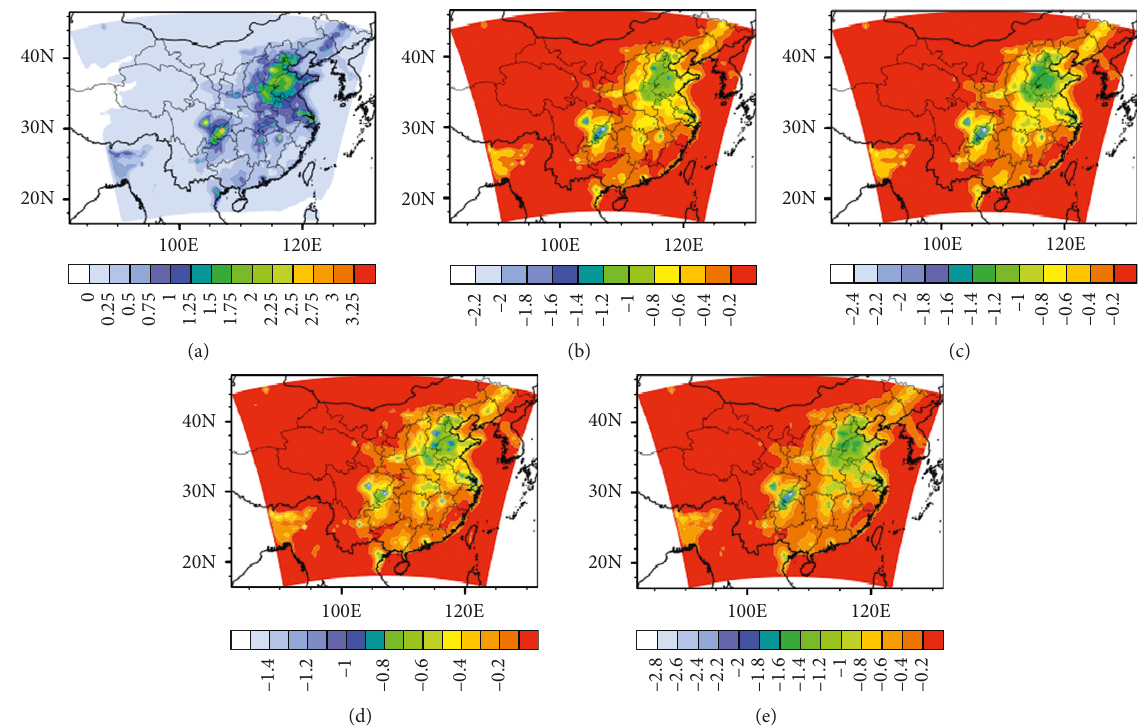
Figure 3: Differences between the four modes and the total ground surface concentrations of BC aerosols calculated by the two schemes ( μ g/m 3 ). (a) BC1. (b) BC2. (c) BC3. (d) BC4. (e) BC